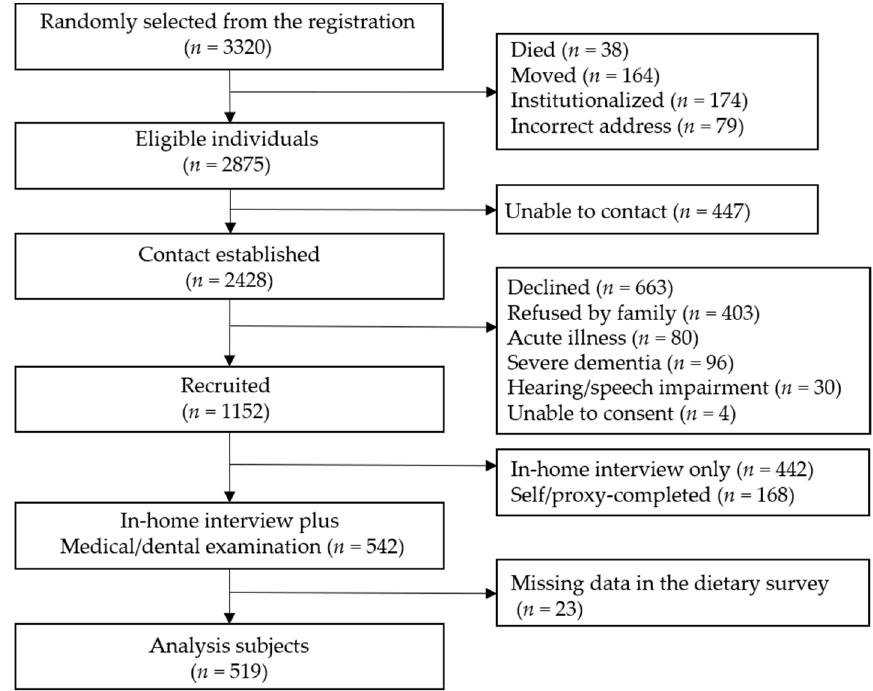
Figure 1. Recruitment of participants.